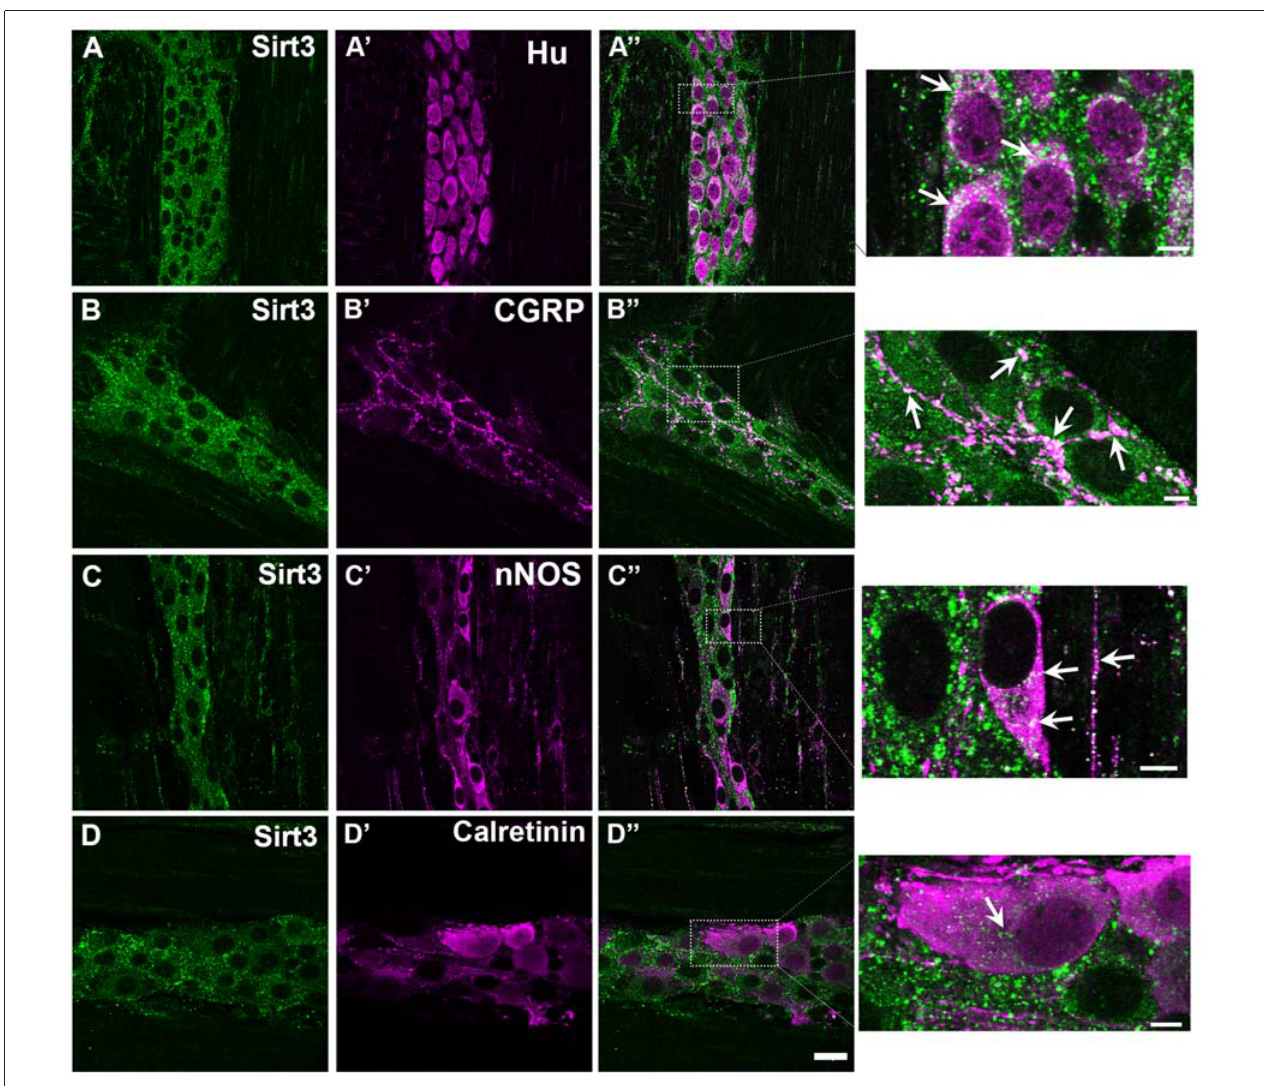
FIGURE 2 | Myenteric neurons in the mouse colon express Sirt3 . Panels show confocal fluorescence microscopy images of dual-label immunohistochemistry for Sirt3 (green, A–D ) and either the neuronal marker HuC/D (magenta, A’ ), calcitonin gene-related peptide (CGRP; magenta, B’ ), nNOS (magenta, C’ ) or calretinin (magenta, D’ ). Overlays of each combination are shown in (A”–D”) . The areas demarcated by the dashed boxes in the overlay images are shown as enlarged images in the panels at far right. Arrows in these images highlight several regions of co-localization. The scale bar in D” = 20 µ m and applies to (A–D”) . All scale bars in the enlarged images at right = 5 µ m. Labeling is representative of experiments performed on tissue from a minimum of three